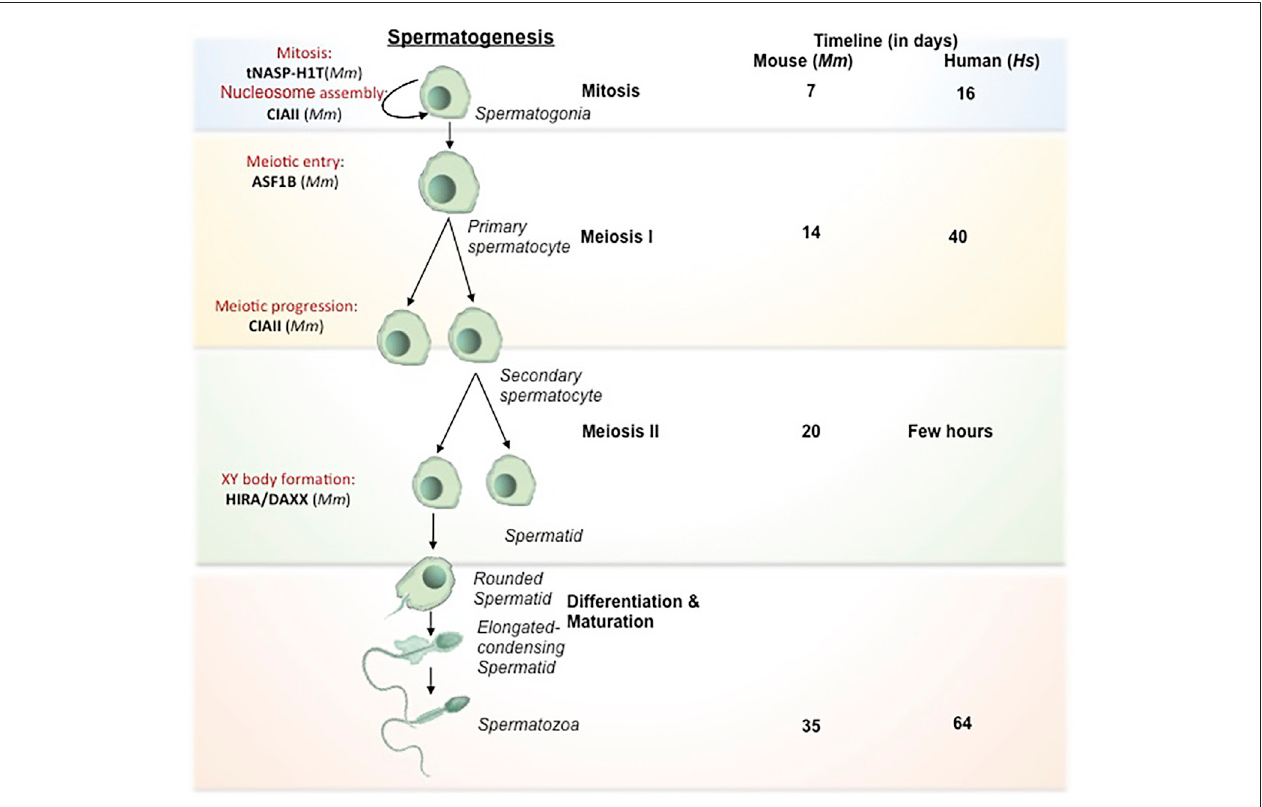
FIGURE 1 | Histone chaperones in different stages of spermatogenesis. Schematic representation of spermatogenesis along with the timeline has been depicted. The transformation from germ cells to gametes is subdivided into 4 stages based on the key processes involved viz. mitosis (self renewal of germ cells), meiosis I (reduction division) meiosis II (equational division similar tomitosis) and differentiation/maturation (transformation tofunctional, fertilizationcompetent spermtaozoa). The functionalimplicationofdifferenthistonechaperonesinthecorrespondingstagesofspermatogenesisismentioned.NASPandCIAIIareinvolvedintheselfrenewal of spermatogonial cells. ASF1B takes part in the regulation of mitotic to meiotic shift while CIAII regulates the meiotic progression in the spermatocyte. HIRA and DAXX are involved in the XY body formation in the pachytene spermatocytes just before the entry to the differentiation. During the spermiogenesis, the differentiation phase of the mature spermatids to the spermatozoa, the protamine loading is mediated by CAF1 and NASP. Abbreviation-Mm, Mus musculus .